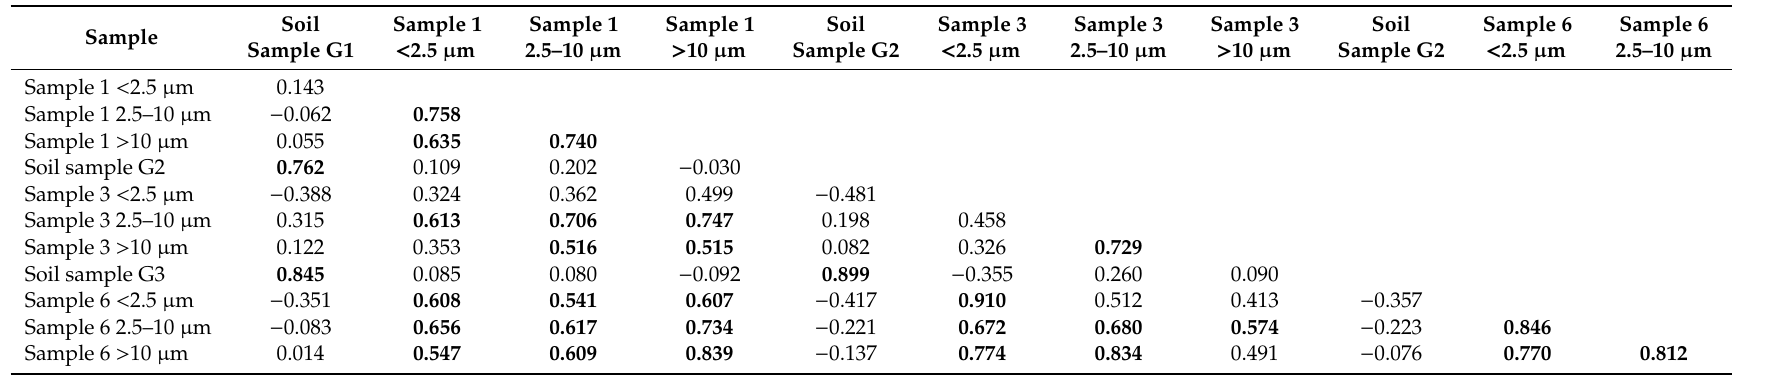
Table 2. Spearman’s correlation coe ffi cient ρ of the percentage contribution of anthropogenic mineralogical phases between analyzed soils (G1, G2, G3) and related atmospheric particle sites (Nos. 1, 3, 6); ( N = 12); the significant correlations ( p < 0.05) are marked by bold